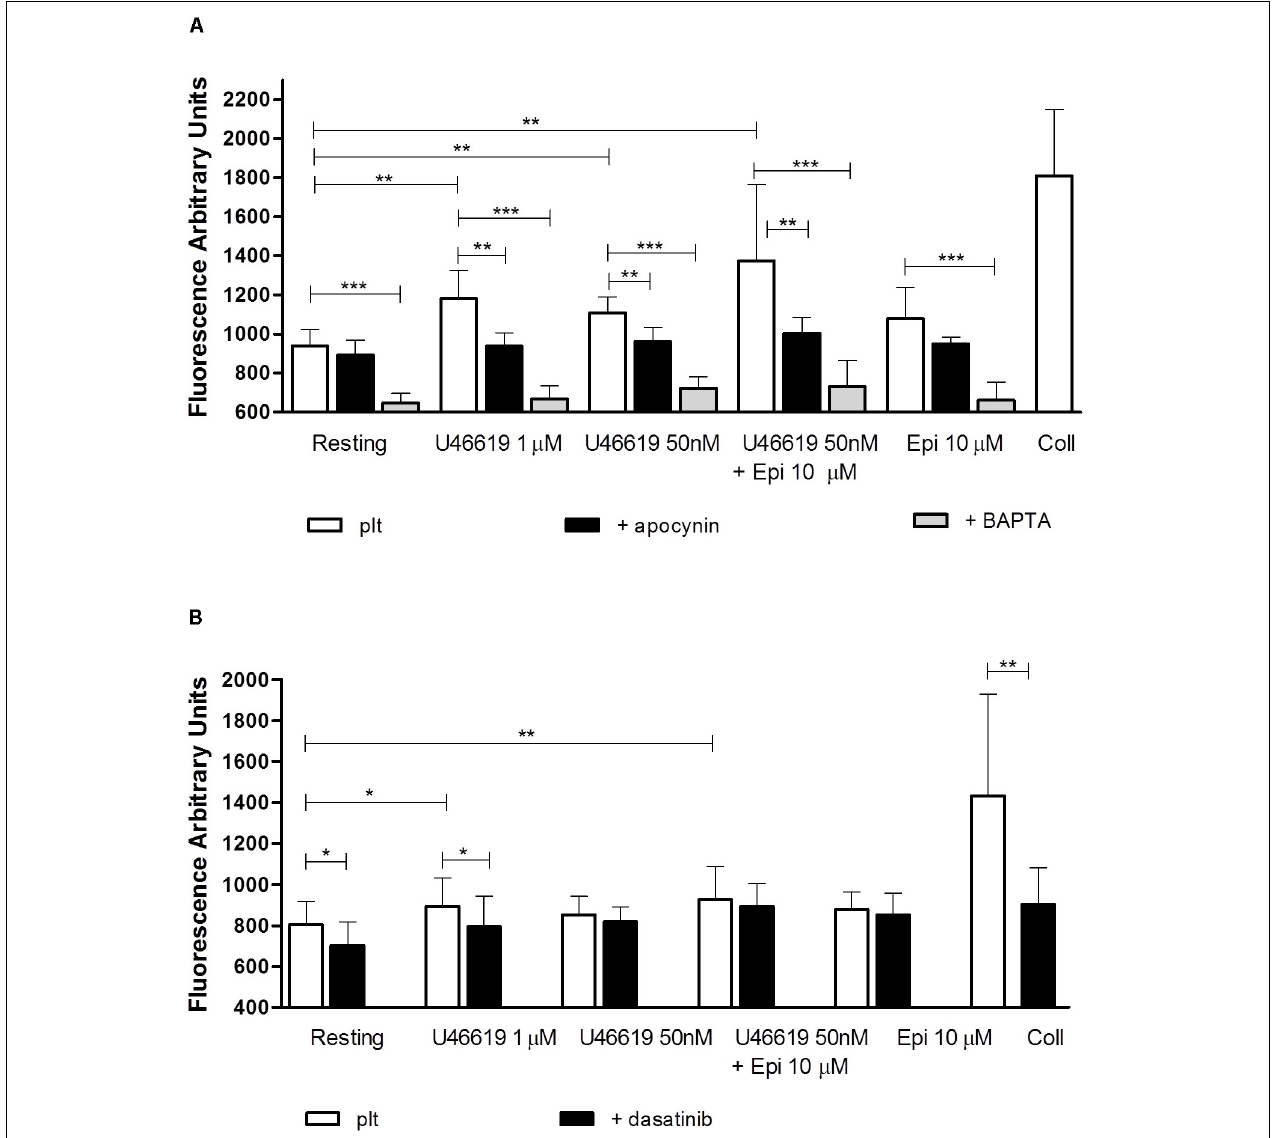
FIGURE 6 | Reactive oxygen species generation (measured as Fluorescence Arbitrary Units-FUA) induced by agonists in washed platelets in presence of apyrase VII 10 U mL − 1 , ASA 100 µ M and eptifibatide 10 µ g mL − 1 (A,B) . Platelets were pre-treated with the NADPH oxidase inhibitor apocynin 300 µ M, the intracellular calcium chelator BAPTA-AM 20 µ M (A) , or the tyrosine kinase inhibitor dasatinib 150 nM (B) . Repeated-measures One-way ANOVA, with the Newman–Keuls test for post hoc analysis were applied to compare independently each platelet agonist in the presence or absence of inhibitors with resting conditions. Data are expressed as Mean ± SE. Indicates the signficance level: ∗ P < 0.05, ∗∗ P < 0.01, ∗∗∗ P < 0.0001.